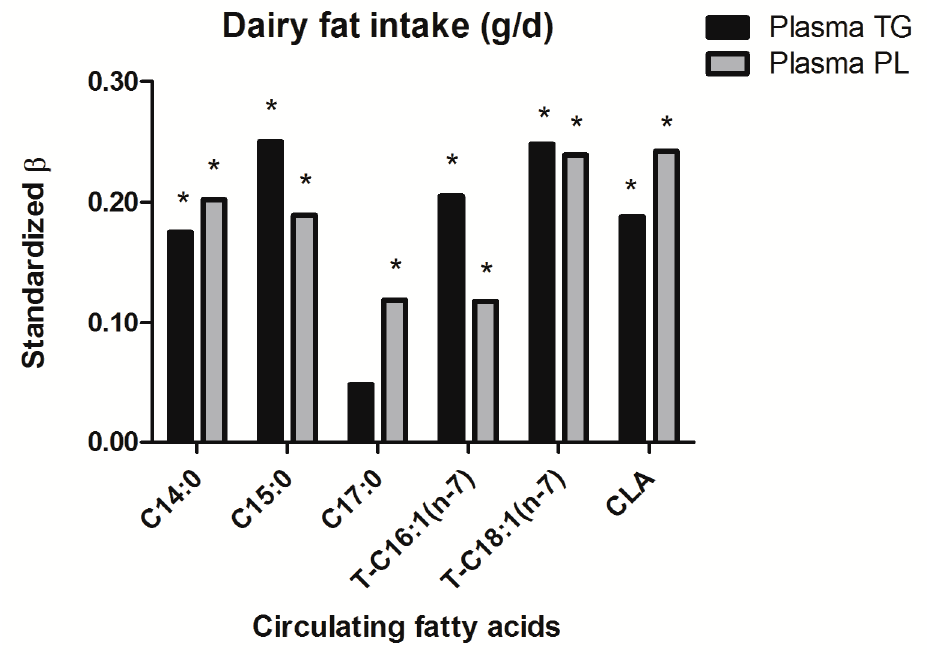
Figure 1. Association between circulating fatty acids from plasma triglycerides and phospholipids and dairy fat intake, adjusted for energy intake. *Equal or below significance level P ≤ 0.05.